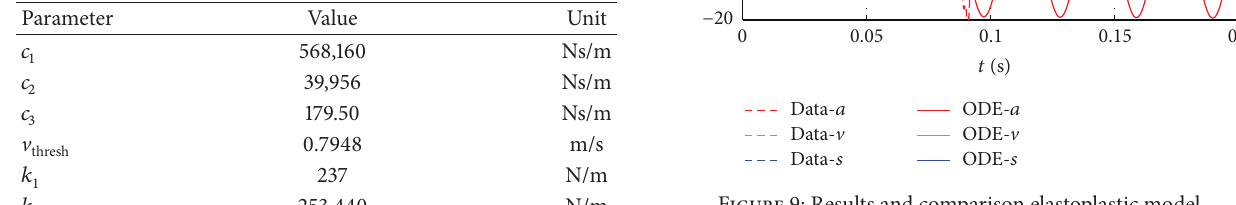
Figure 9: Results and comparison elastoplastic model.